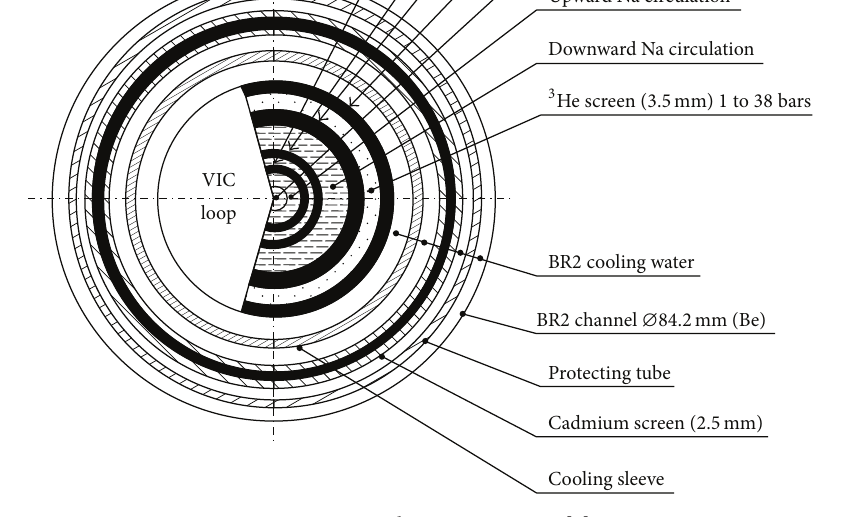
Figure 28: VIC loop cross-section [3].